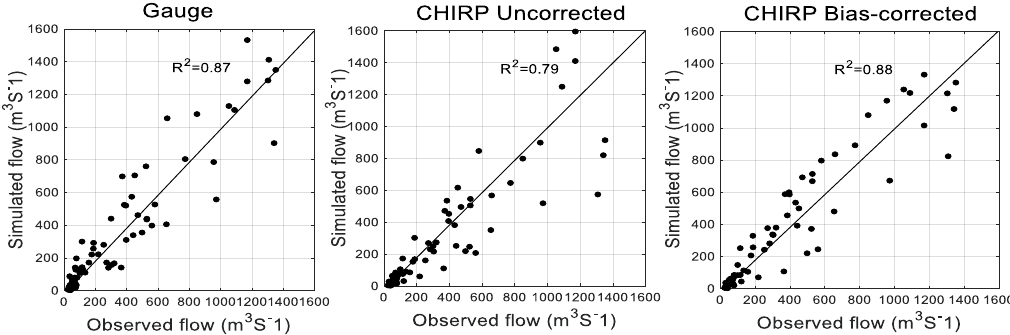
Figure 10. Monthly scatter plots of the observed flow against the simulated flow using the gauge-based, the uncorrected, and the bias-corrected CHIRP rainfall data at Katar catchment from 1986–1991.